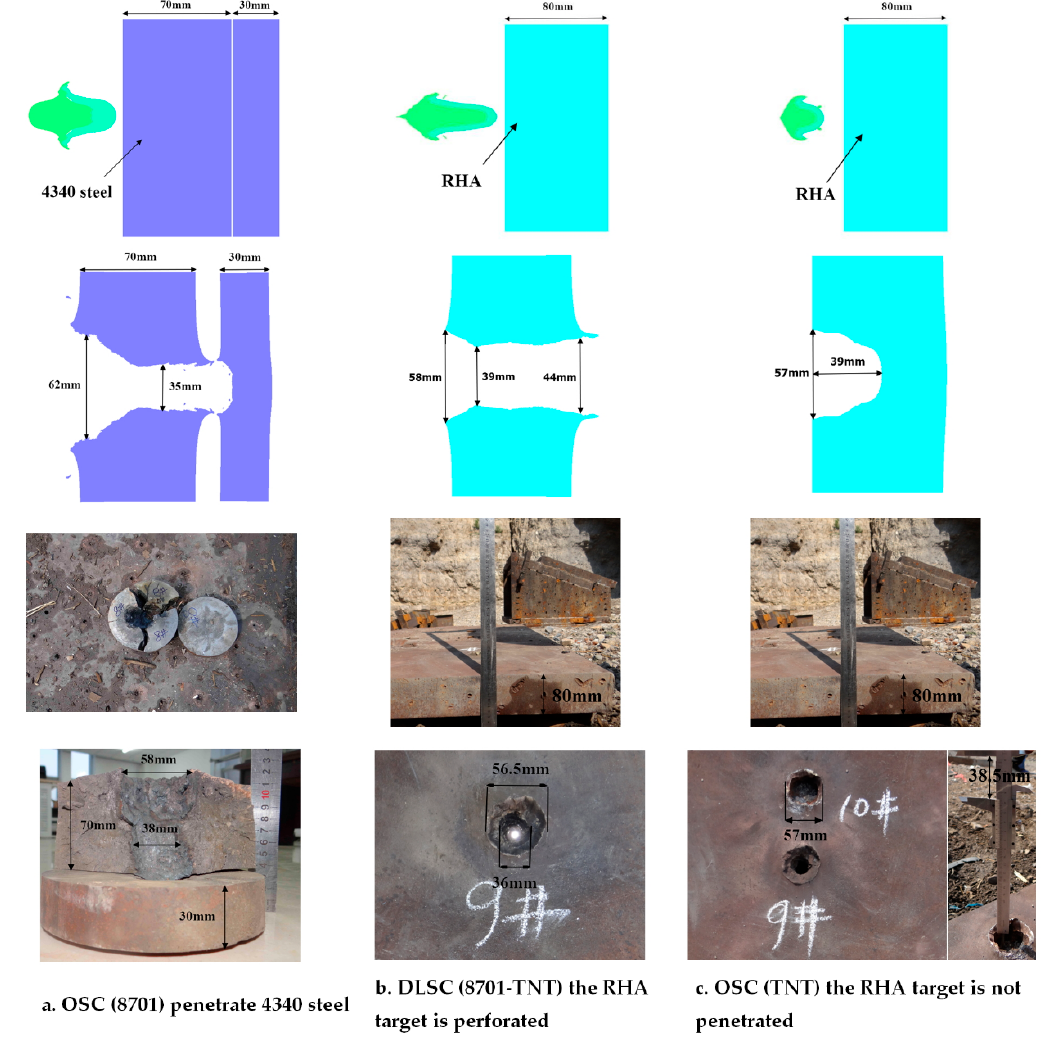
Figure 8. EFP penetration experimental results of three shaped charges: OSC (TNT), DLSC (8701-TNT) and OSC (8701).